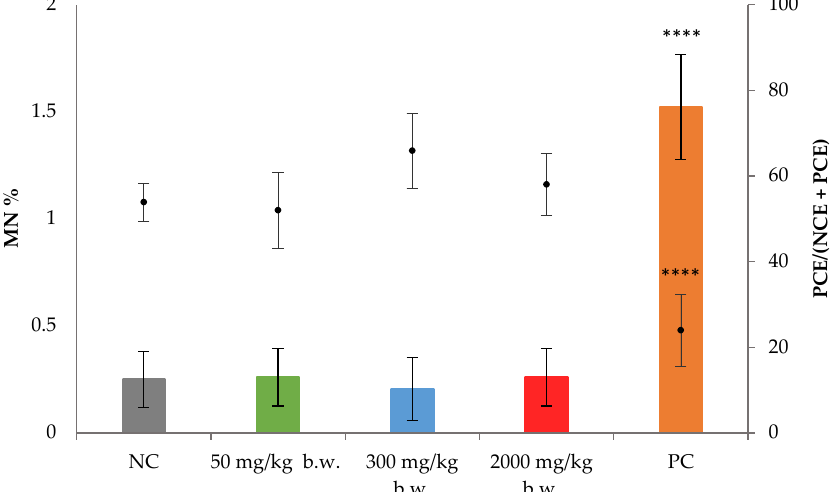
Figure 1. Results of the in vivo erythrocyte MN test after 28-day oral administration of the silver-kaolin formulation. The graphic shows the mean ± SD of the MN% in bars and the PCE ratio over the PCE + NCE (dots) for each group. ****: ( p < 0.001) statistically significant different from negative control. NC: negative control, PC: positive control.